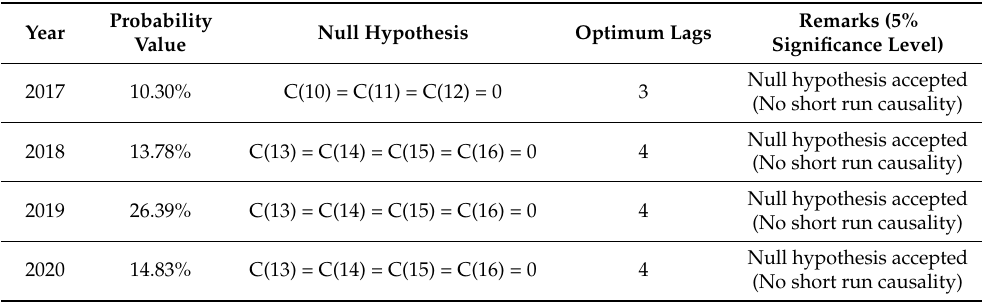
Table 8. Wald Test for short run causality between sustainability performance and share performance (2017 to